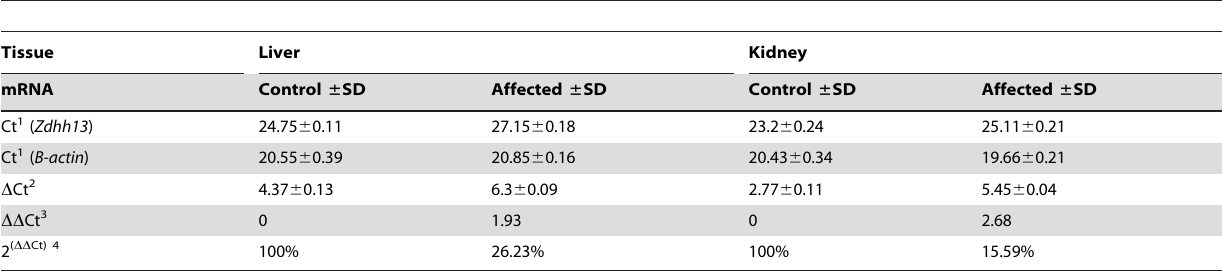
Table 3. Real-time quantitative RT–PCR of Zdhhc13 mRNA in mouse tissues.